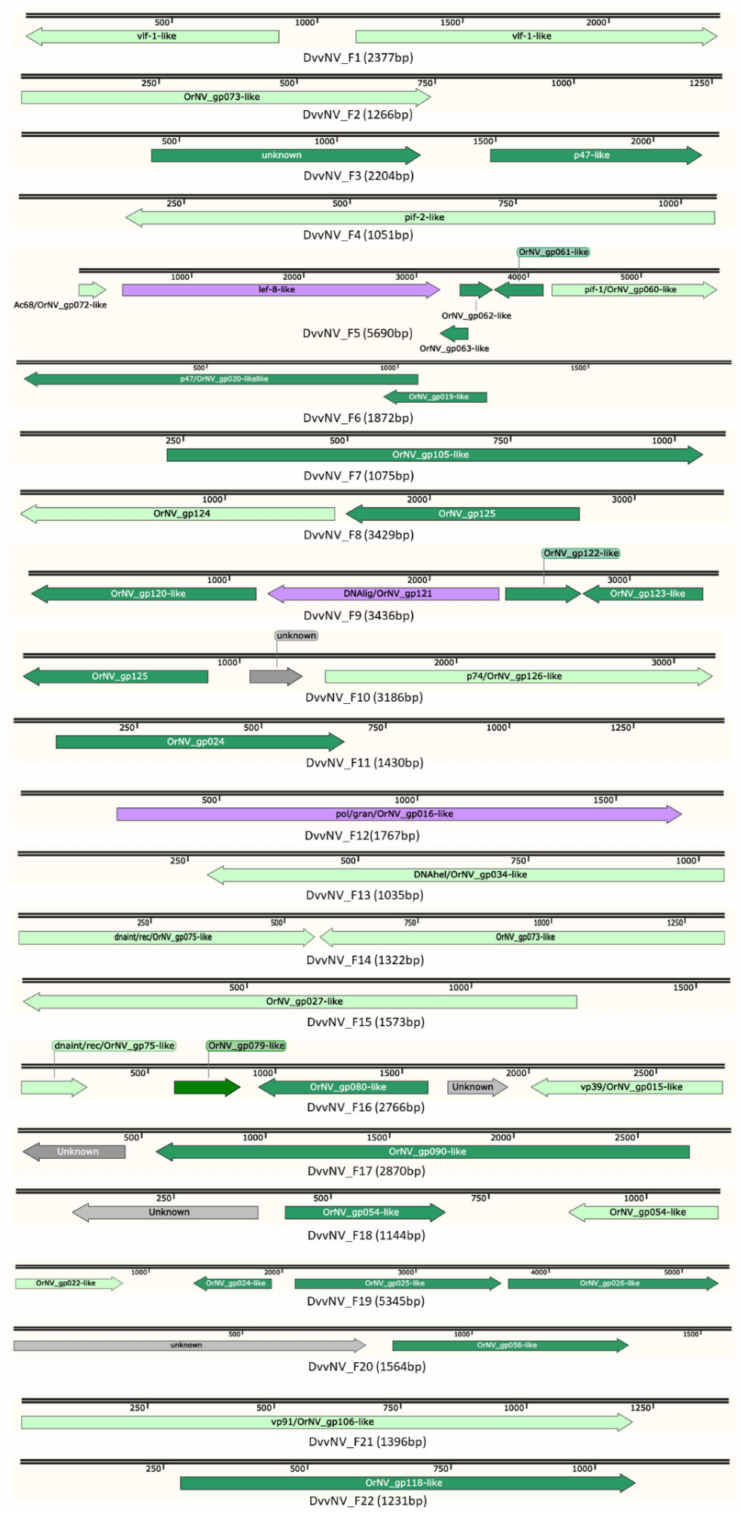
Figure 3. Map of the 22 DvvNV genomic fragments. Arrows indicate ORFs and ORF orientation. Green, ORFs that hit nudiviruses; purple, core genes; grey, unknown ORFs; light green, partial